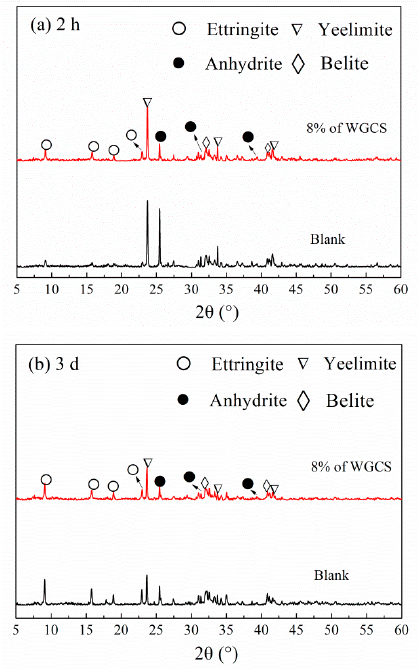
Figure 6. XRD patterns of WGCS–CSA paste. ( a ) 2 h; ( b ) 3 d.